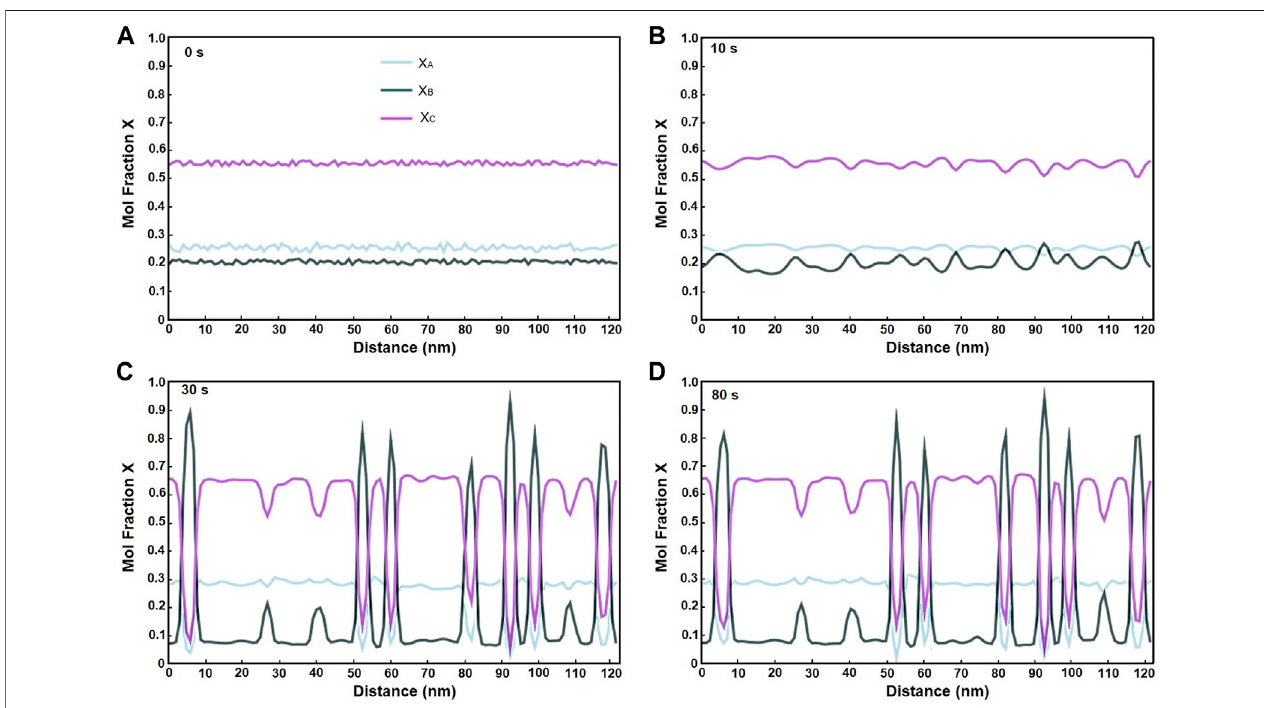
FIGURE9| Simulatedconcentrationpro fi lesoftheA – B – CalloyforcaseIIIwith X A =0.25 , X B =0.20 ,and X c =0.55 agedat800 Kfor (A) 0 s, (B) 10s, (C) 30 s,and (D) 80 s.